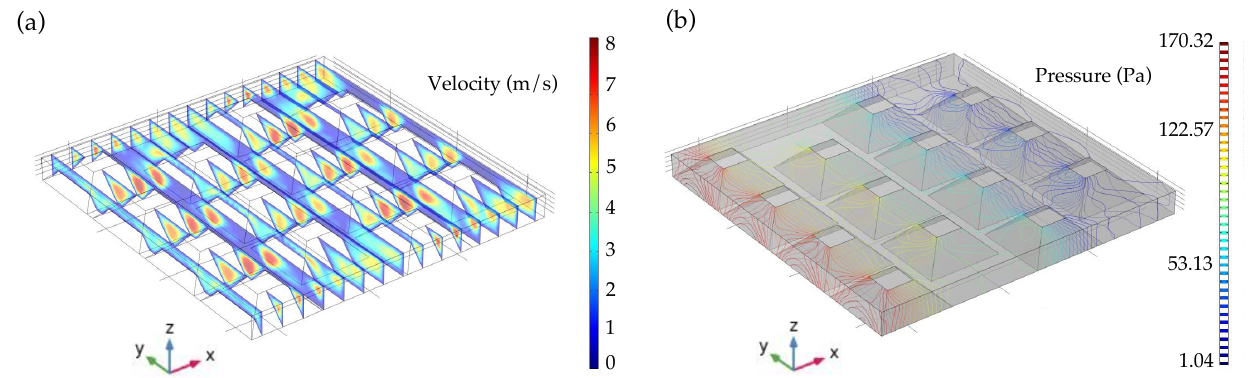
Figure 6. Air flow through a PCM–air heat exchanger panel: ( a ) steady-state air velocity magnitude and ( b ) pressure distributions for the PYO design, for u inlet = 2 m/s and h = 12.19 mm.